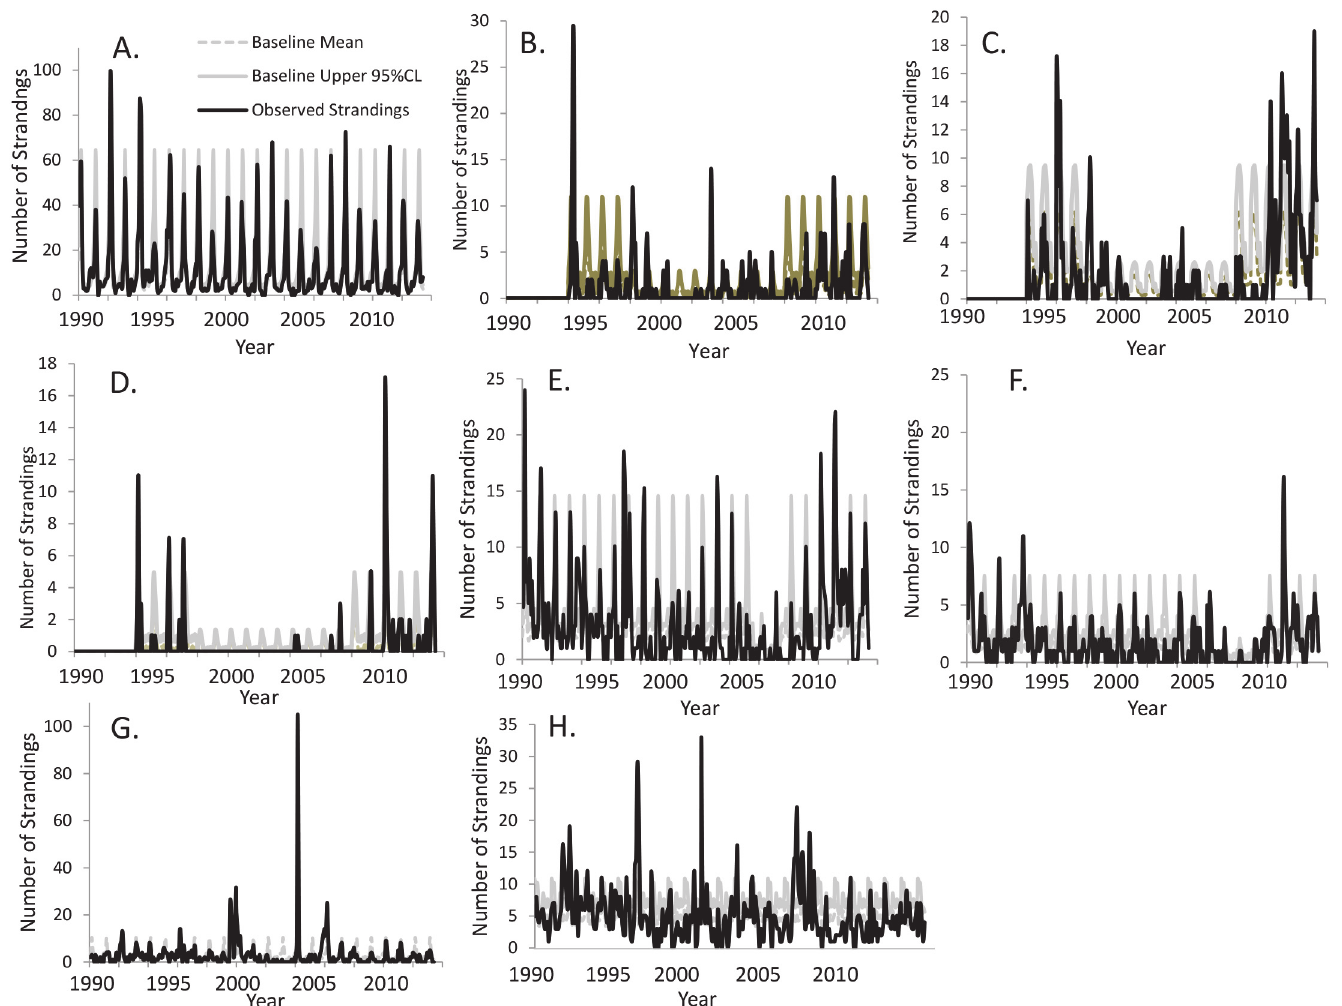
Fig 3. Baseline historical stranding numbers of common bottlenose dolphins ( Tursiops truncatus ) in the northern Gulf of Mexico, fitted values, and the upper 95% confidence limit from negative-binomial regression model for regions with statewide annual increases during the ongoing northern Gulf of Mexico unusual mortality event; A) Texas, B) Western Louisiana, C) Barataria Bay, Louisiana D) Northern Louisiana, E) Mississippi, F) Alabama, G) Florida Panhandle, H) Western Florida.